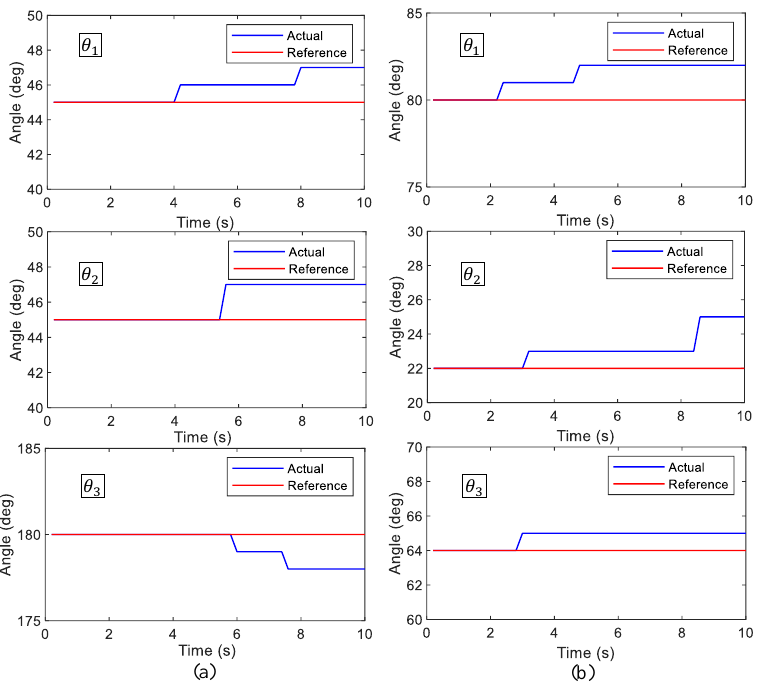
Figure 9. The variation of the hinge angles measured through hinge encoders during the sample locomotion cases. ( a ): case 1, and ( b ): case